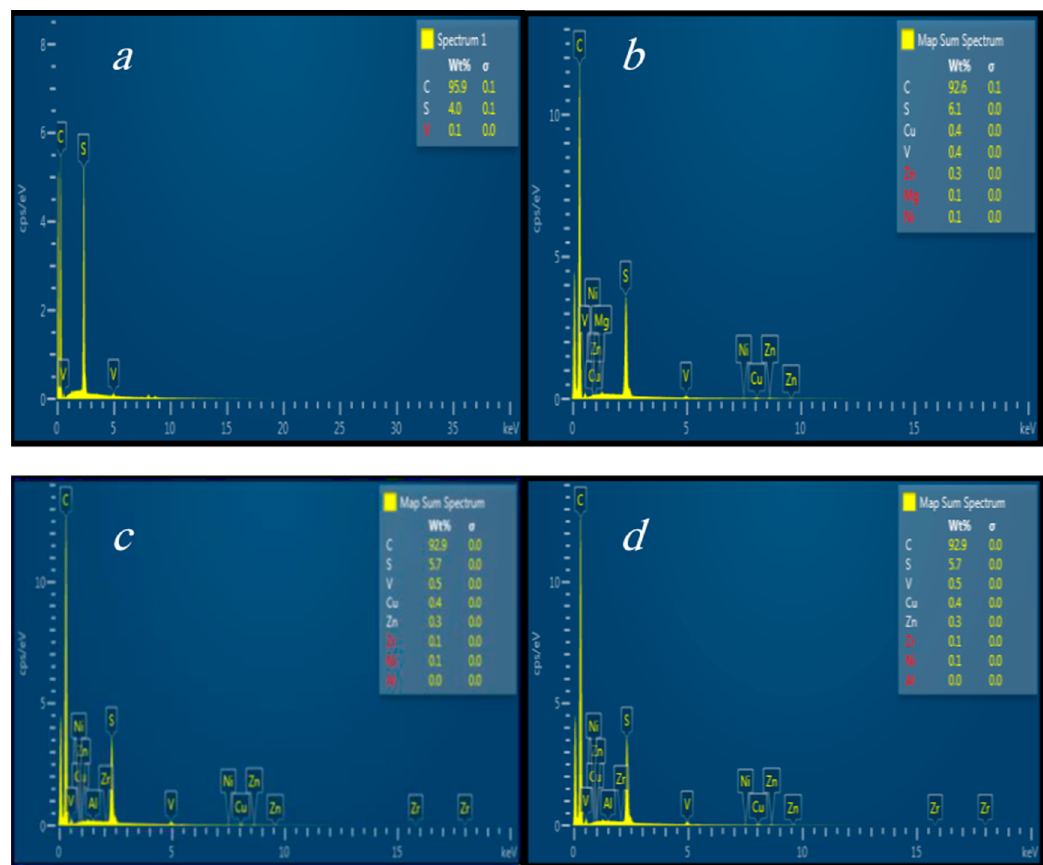
Figure 3. EDX analysis of fly ash ( a ) before treatment, ( b ) after 1st cycle of treatment, ( c ) after 2nd cycle of treatment, ( d ) after 3rd cycle of treatment. Table 3. Concentrations of major elements present in the waste after treatment obtained by ICP.